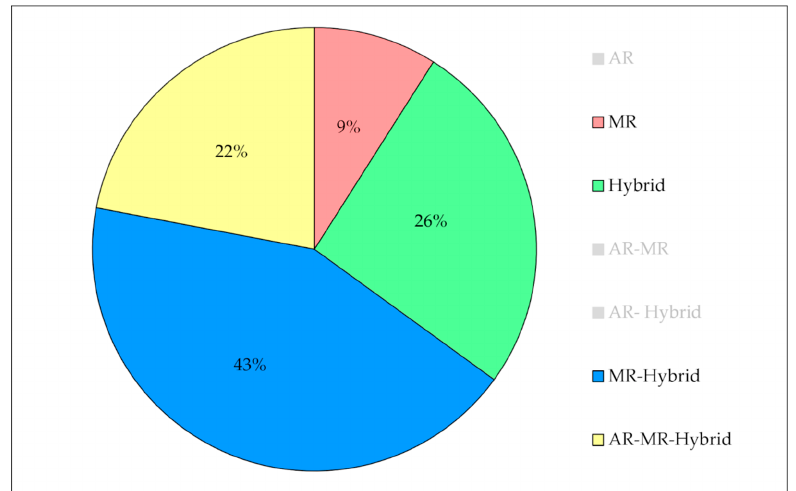
Figure 2. The pie chart shows the percentages of studies using commercial (22%) and custum- made (78%) simulators.